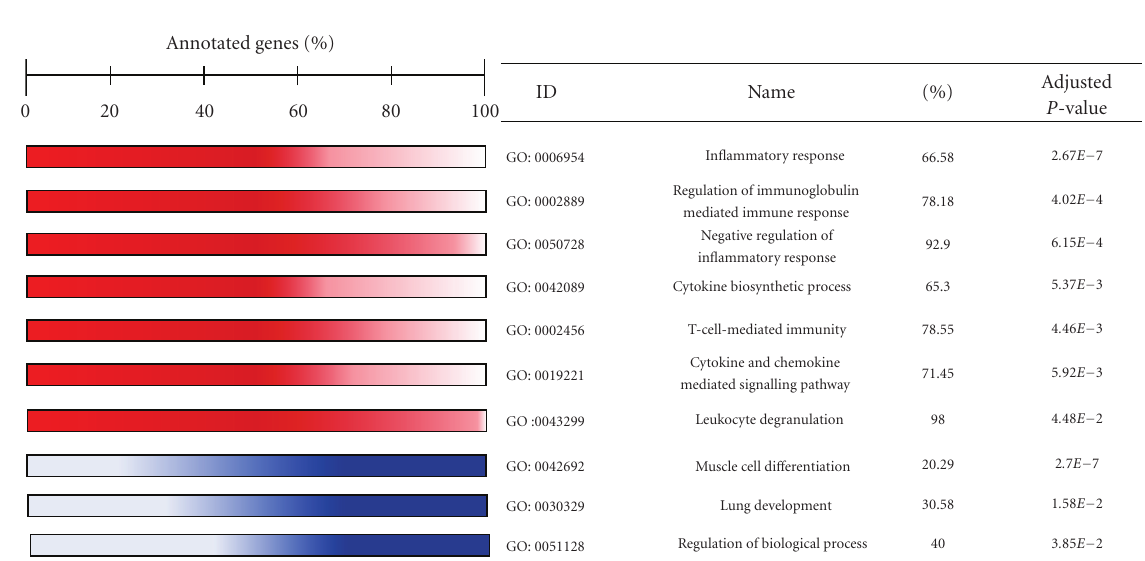
Figure 1: Biological pathway up- and downregulated in OVA versus pEGFP-GAL. Red indicates the biological processes overrepresented in the OVA group (percentage > 50), and blue indicates that these pathways are overrepresented in the pEGFP-Gal-3 group (percentage < 50).